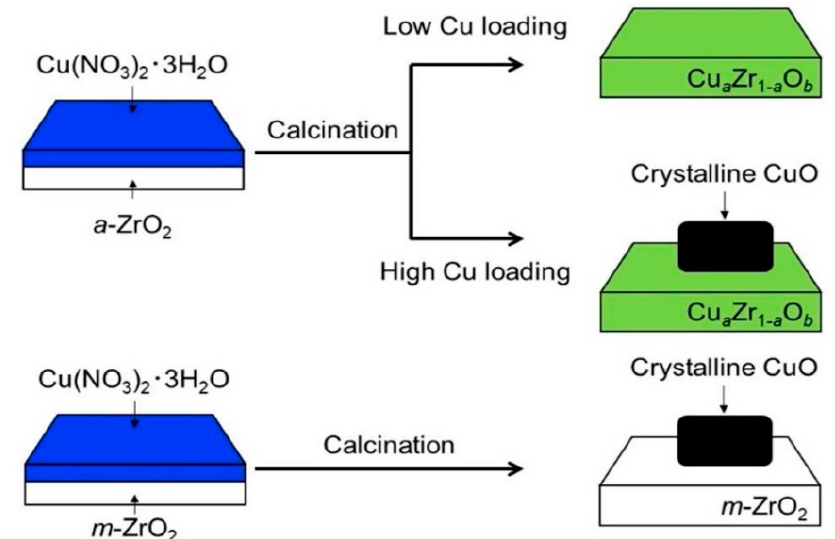
Figure 3. Proposed formation mechanism of Cu a Zr 1 − a O b , CuO/Cu a Zr 1 − a O b , and CuO/m-ZrO 2 . Reprinted with permission from ref. [111]. Copyright 2018 American Chemical Society.